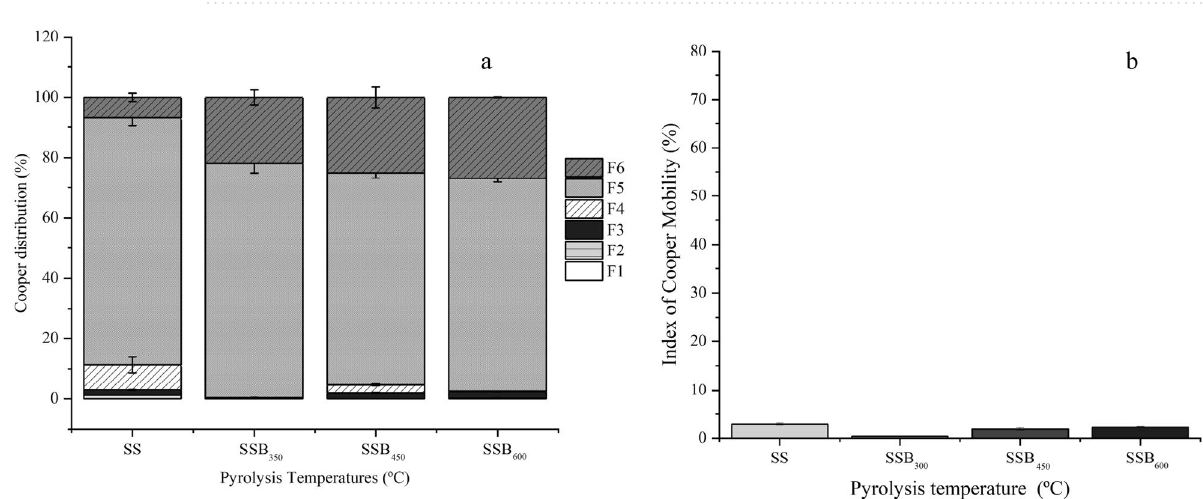
Figure 5. Cooper fraction distribution ( a ) and mobility index ( b ) of sewage sludge biochar produced at 350 (SSB 350 ), 450 (SSB 450 ) and 600 (SSB 600